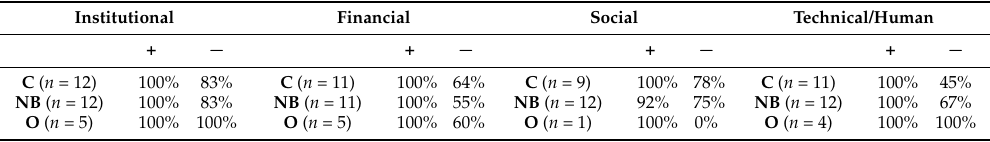
Table 2. Interviews Indicating a Presence and/or Absence of Elements of